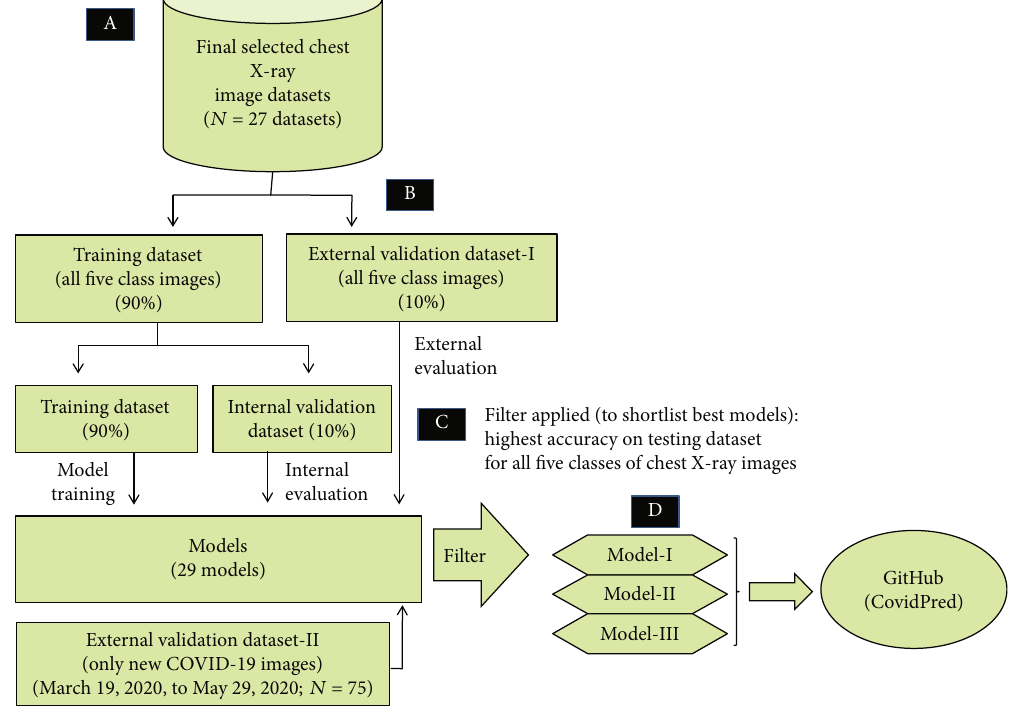
Figure 3: Flowchart depicting the methodology used for the training, evaluation, validation, and selection of AI-based models available on the GitHub